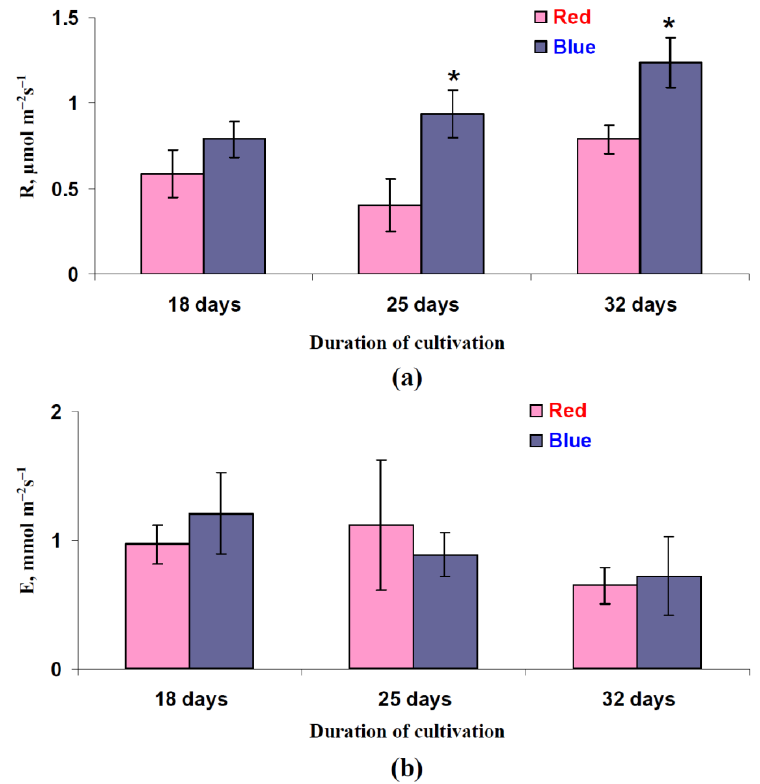
Figure 3. Influence of the red (marked as “Red”) and blue (marked as “Blue”) illumination variants during lettuce cultivation on rates of the dark respiration (R) ( a ) and transpiration (E) ( b ) ( n = 5–7). Illumination spectra are shown in Figure 1. * differences between plants cultivated under the red and blue illumination variants were significant ( p < 0.05).